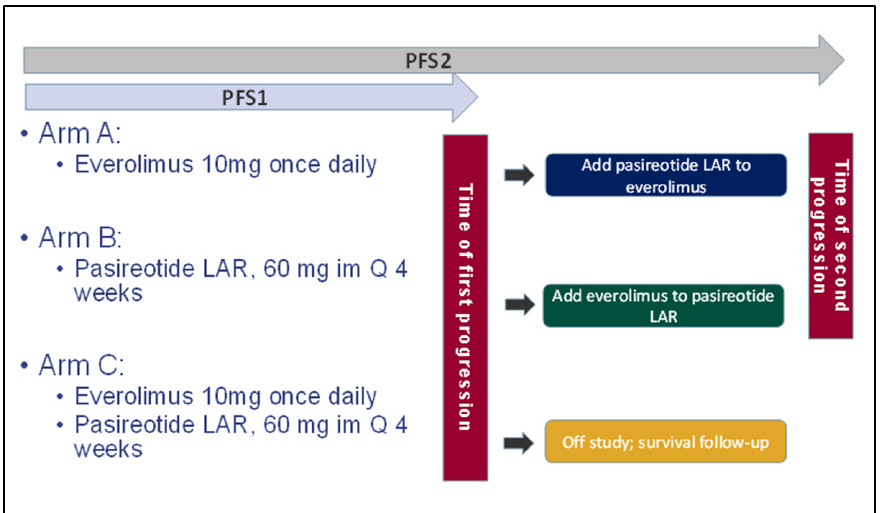
Figure 1. Randomization of patients enrolled on study to single agent everolimus, pasireotide LAR, or the combination. PFS1 was measured from initiation of treatment until the time of initial progression. PFS2 is the interval from treatment initiation until progression on the combination regimen. Note that PFS1 is the same as PFS2 for Arm